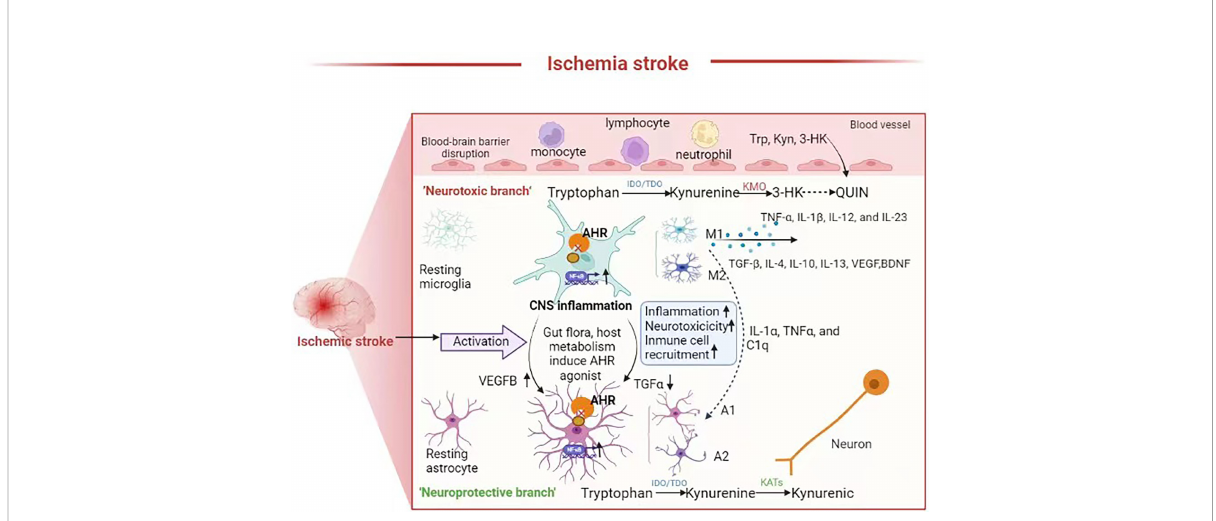
FIGURE 2 Neuroin fl ammation in the brain after stroke, the role of AHR and tryptophan metabolites in neuroin fl ammation. Microglia and astrocytes are activated and interact with each other to mediate neuroin fl ammation following ischemic stroke Some metabolites such as 3-HK, Kyn, QUIN produced by tryptophan metabolism can cross the BBB plays a neuroprotective or neurotoxic role. Gut fl ora and the host tryptophan metabolism produce AHR agonist. In astrocytes and microglia, AHR can inhibit pro-in fl ammatory nuclear factor- k B (NF- k B) signaling, and reduction of AHR agonists after gut microbiota dysbiosis result in an upregulated neuroin fl ammation and neurotoxic responses and immune cell recruitment, which are ampli fi ed through microglia-astrocyte